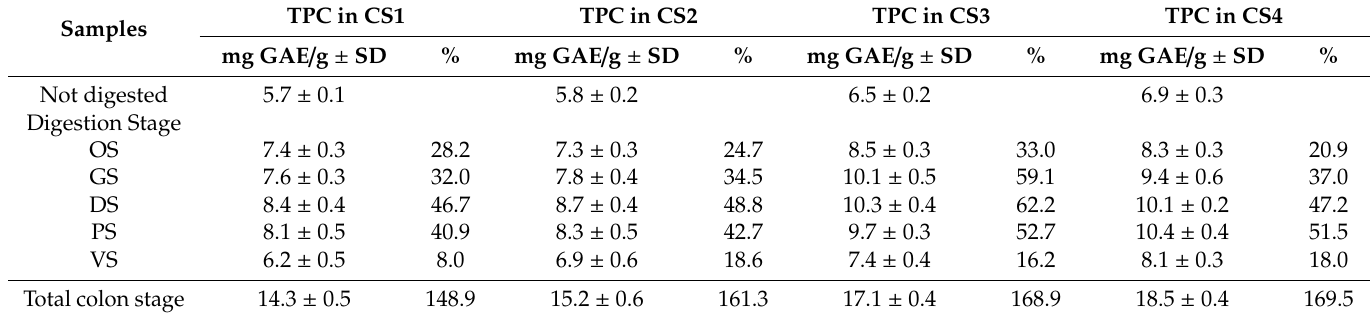
Table 5. Bioaccessibility of total phenolic content evaluated by the Folin-Ciocalteu method in non-digested samples and during the simulated in vitro digestion.